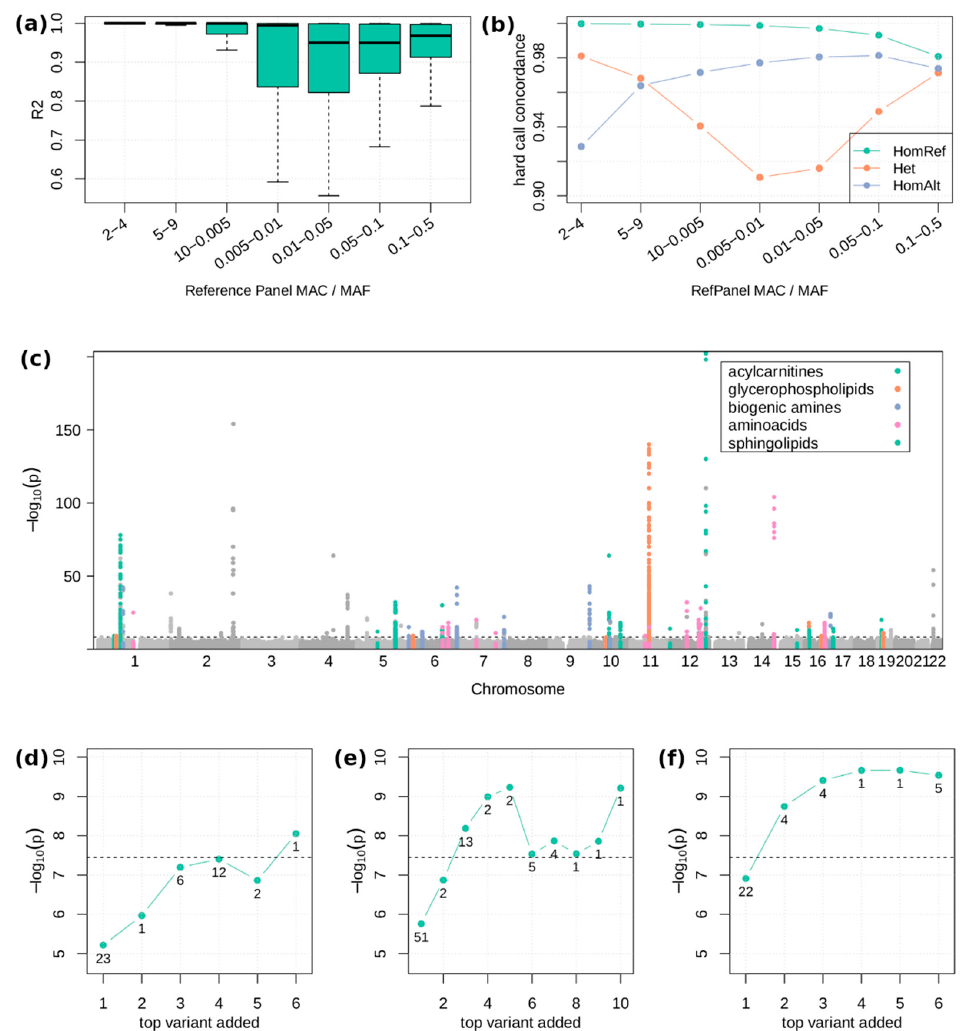
Figure 2. Main results of the metabolite ExWAS. ( a ) Squared correlation of imputed dosages and sequenced genotypes in 181 validation samples split into bins based on MAC or MAF in the reference panel. Number of variants included in the bins from left to right: 2–4: 1851; 5–9: 4412; 10–0.005 = 24,868; 0.005–0.01 = 24,232; 0.01–0.05 = 53,488; 0.05–0.1 = 19,669; 0.1–0.5 = 57,563. ( b ) Concordance of imputed and sequenced hard calls in 181 validation samples split into bins based on MAC and MAF in the reference panel. ( c ) Manhattan plot of the single-variant associations of all 175 traits. The 85 significant associations listed in Table S4 are highlighted and colored by metabolite class. The dashed horizontal line indicates the significance threshold of 5.5 × 10 − 9 . ( d ) to ( f ) − log10 p -value of the skato gene test, adding the variants constituting the gene test iteratively for tryptophan— TDO2 ( d ), sphingomyeline C18:0— CERS4 ( e ), and carnitine— SLC22A5 ( f ). In each step i on the x -axis, the gene test is computed using only the i variants with the smallest single variant p -value. Below each point, the minor allele count of the added variant is given.